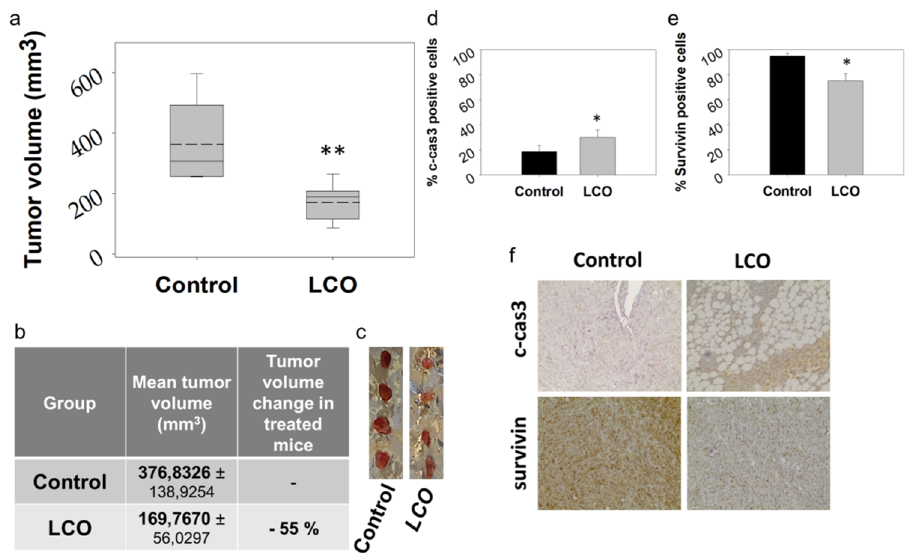
Figure 5. Oral administration of LCO attenuates tumor growth in DA3 breast cancer model in mice. LCO was administered daily to BALB/c mice by oral gavage for 14 days and, on the 12th day, mice were inoculated subcutaneously with DA3 cancer cells (5 × 10 6 cells per mouse). Seven days later, animals were euthanized and the developed tumors were harvested. A statistically significant reduction of ≈ 55% in tumor volume ( p = 0.001, Student’s t -test) was observed in LCO-treated animals compared to the control group. ( a ) Graphical representation of tumor volume distribution (solid lines indicate median and dashed lines indicate mean values), ( b ) mean tumor volume, and ( c ) photographic observation of excised tumors. ( d – f ) Immunohistochemical detection of ( d ) cleaved caspase-3 and ( e ) survivin in tumor tissue from LCO-treated or control mice. ( f ) Representative images showing the effect of LCO administration on survivin andc-cas3 protein levels. The differences in the expression of cleaved cas-3 or survivin in tumor tissue from treated versus control mice are statistically significant ( p = 0.023 or p = 0.024, respectively), as calculated using the SigmaPlot 11.0 statistical software; (* p < 0.05, ** p < 0.005).